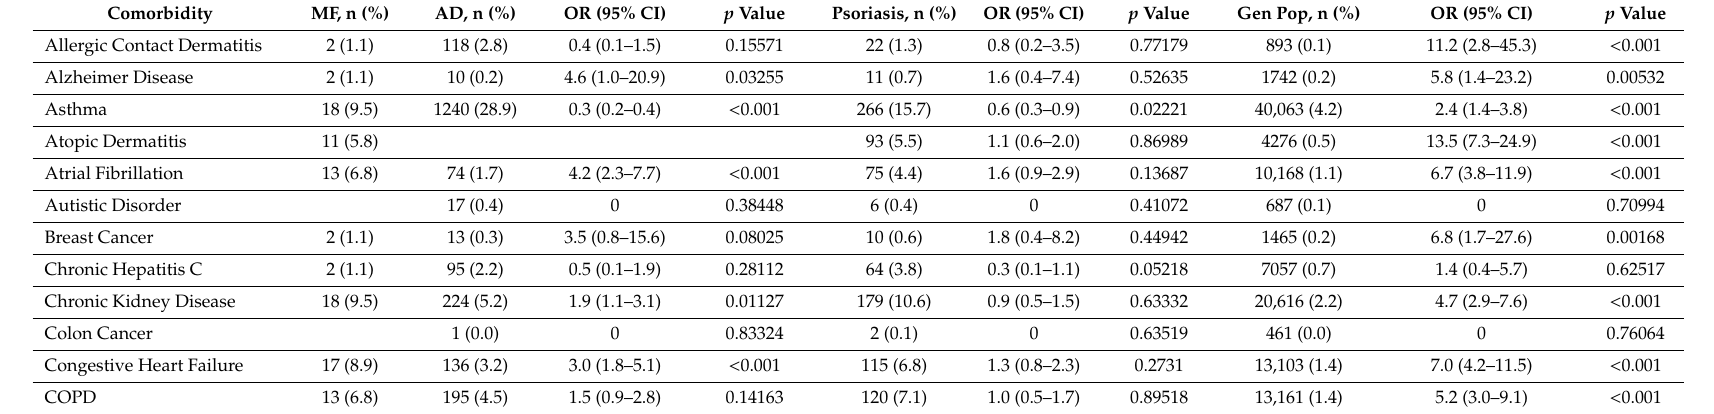
Table A2. Absolute number, percentage, odds ratios and p values of Black / African American patients age 18 years and older with mycosis fungoides and various comorbid conditions, as compared with race-matched controls age 18 years and older with AD, with psoriasis, or within the general population who were seen at the JHHS between January 1, 2013 and January 1, 2019. Data presented for 190 patients with mycosis fungoides (MF), 4287 patients with AD, 1690 patients with psoriasis, and 944,278 patients in the general population (excluding those with MF). AD, Atopic dermatitis; COPD, chronic obstructive pulmonary disease; OR, odds ratio; PN, prurigo nodularis; IBS, inflammatory bowel